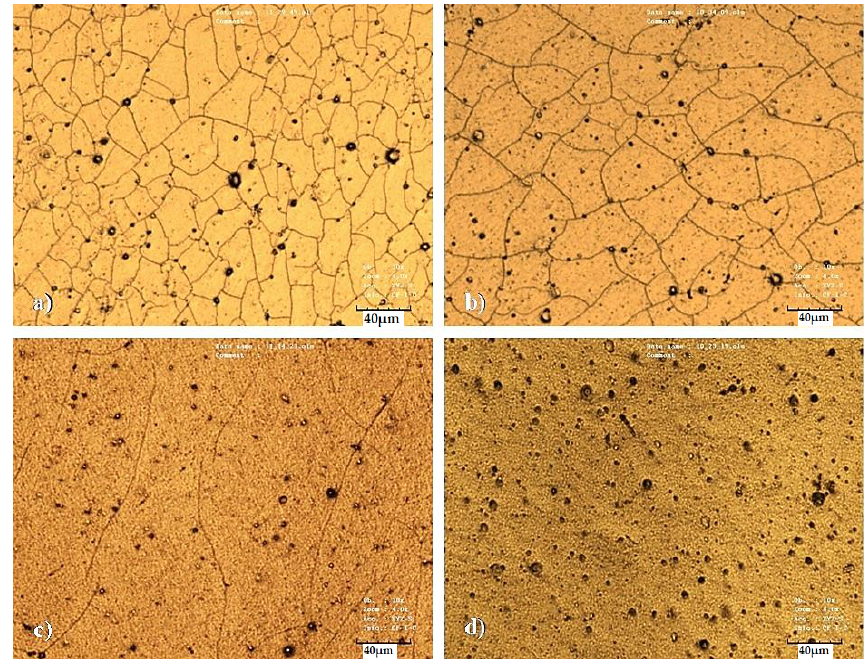
Figure 1. Surface morphology of unheated PLLA samples with sputtered Au and Ti layers. The images were taken by a laser confocal microscope. ( a ) Au and Ti layers of 2 and 28 nm, respectively; ( b ) Au and Ti layers of 5 and 25 nm, respectively; ( c ) Au and Ti layers of 10 and 20 nm, respectively; ( d ) Au and Ti layers of 25 and 5 nm, respectively.